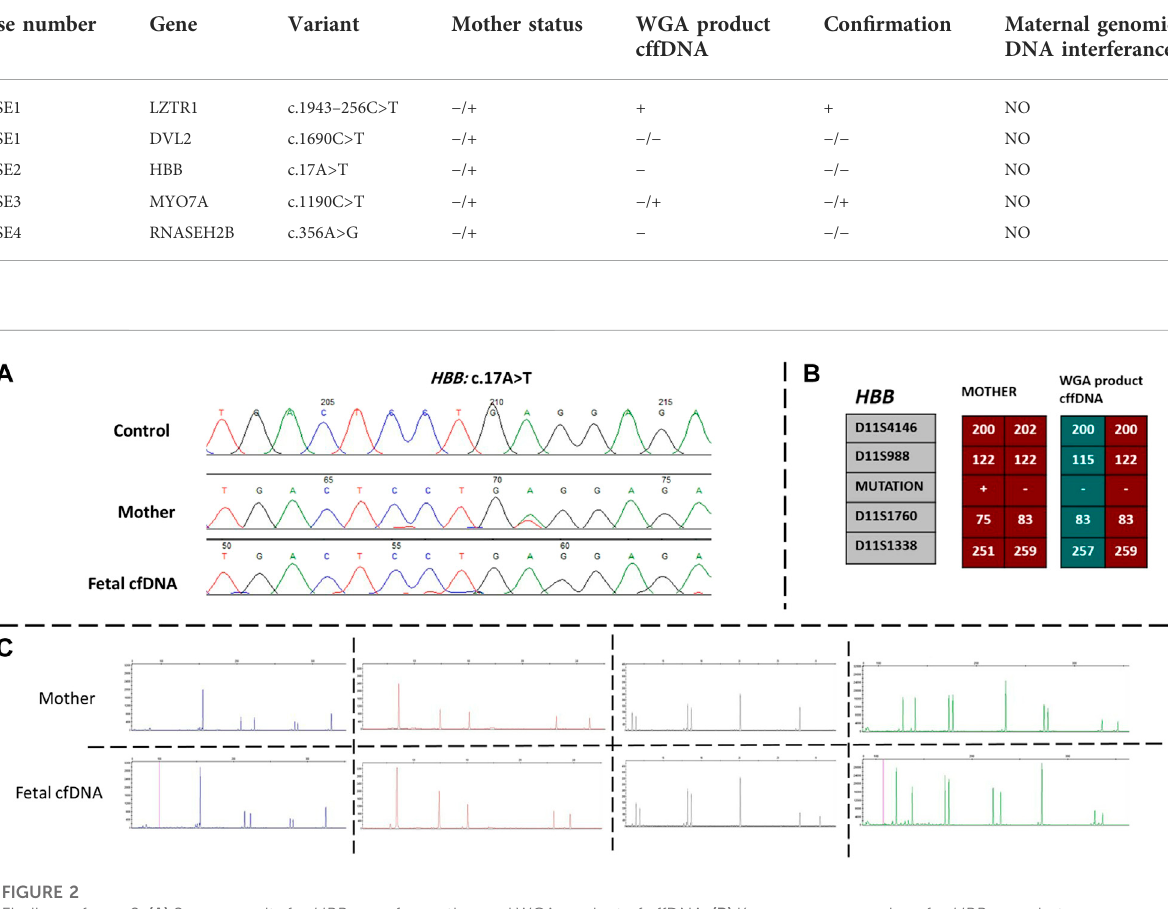
TABLE 2 Summary of results and outcomes observed.